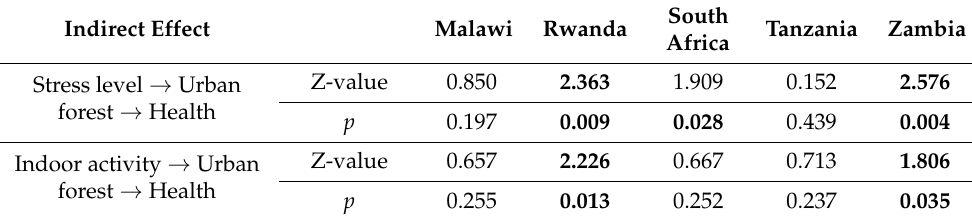
Table 8. The indirect effect of explanatory variables on health outcomes evaluated with the Sobel